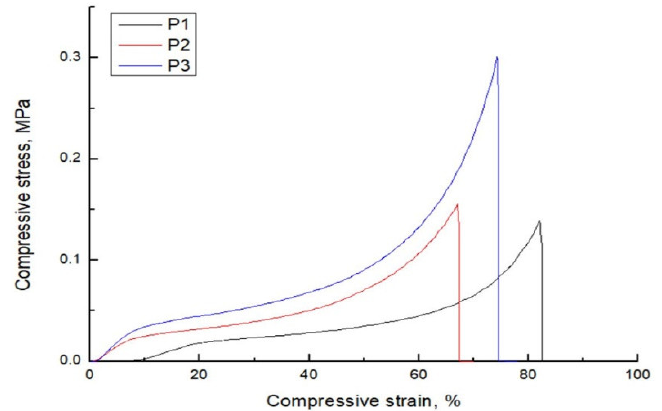
Figure 2. Compressive stress–strain behavior for pectin-based